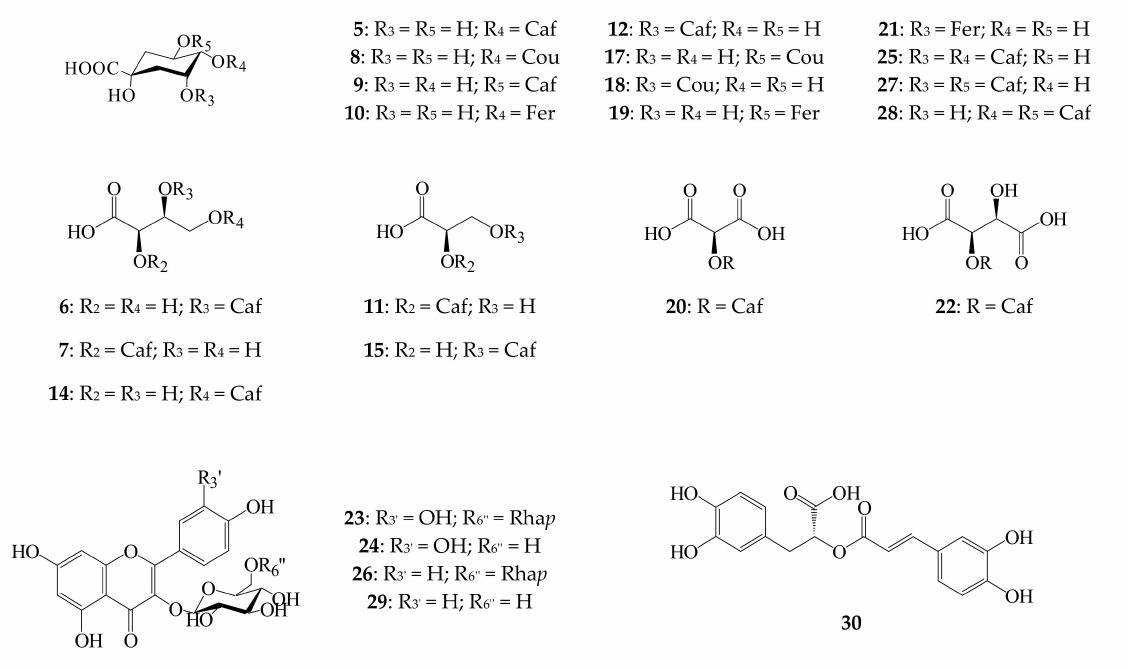
Figure 5. Structures of phenolic compounds found in M. stylosa and M. serrulata .